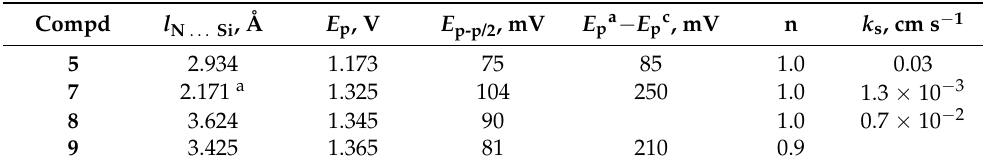
Table 2. Parameters of electrochemical oxidation of silocanes (GC electrode, AN/0.1 M Bu 4 NPF 6 , v = 0.1 V s − 1